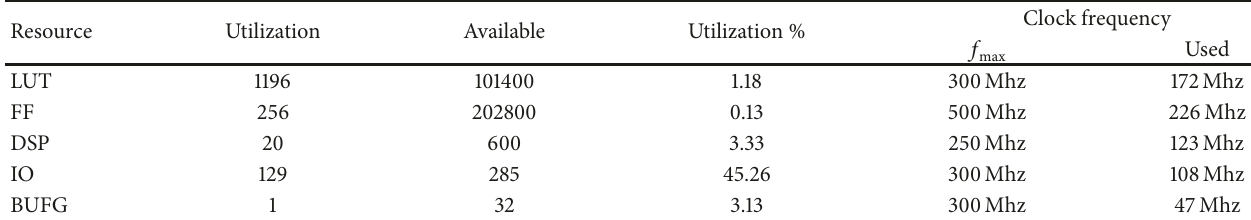
Table 6: Resource utilization of FONCS-2